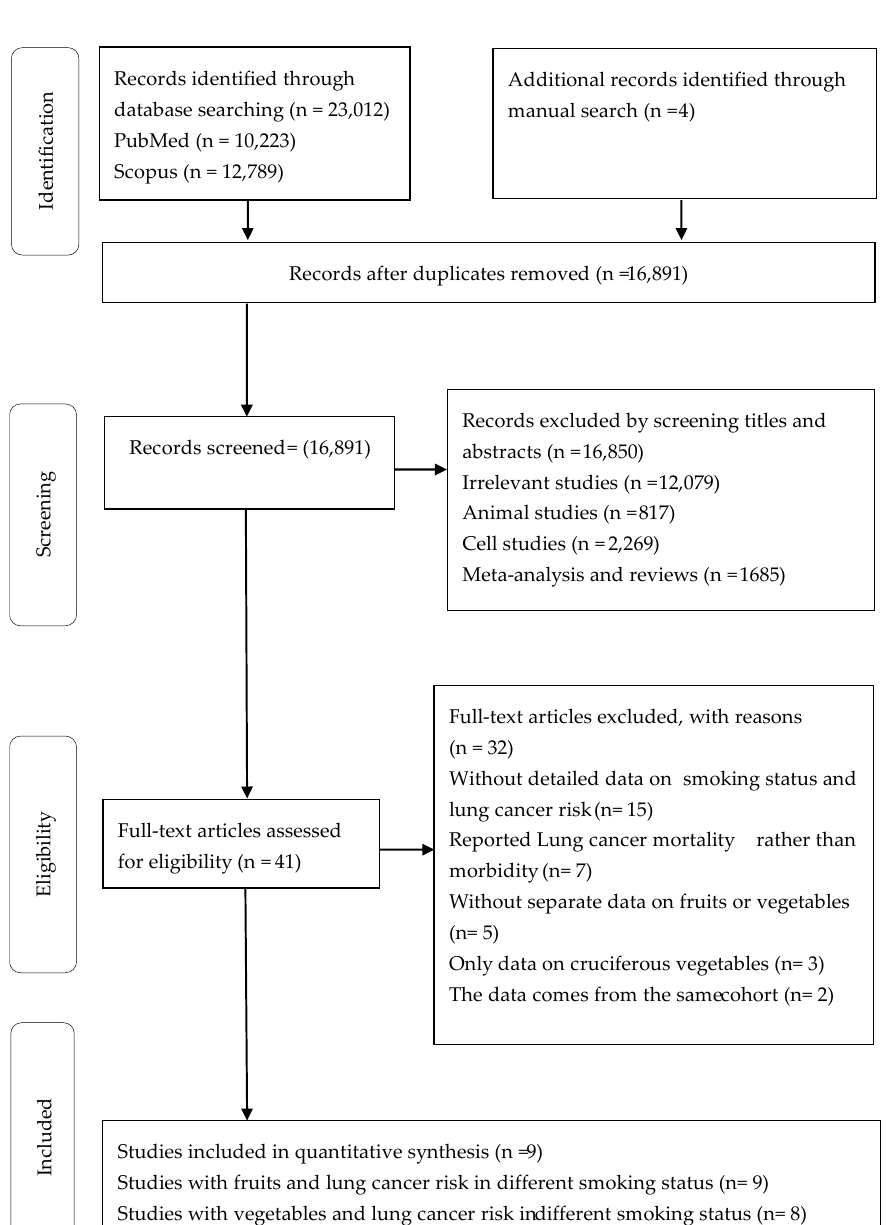
Figure 1. PRISMA Flow Diagram of the study selection procedure showing the number of eligible trials included in the present study.